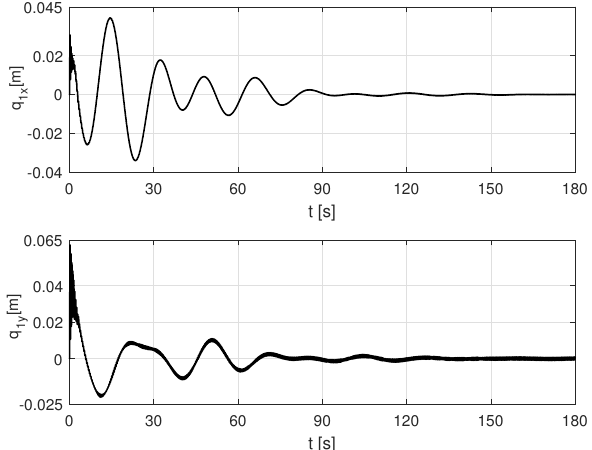
Figure 10. Displacement of appendage 1.